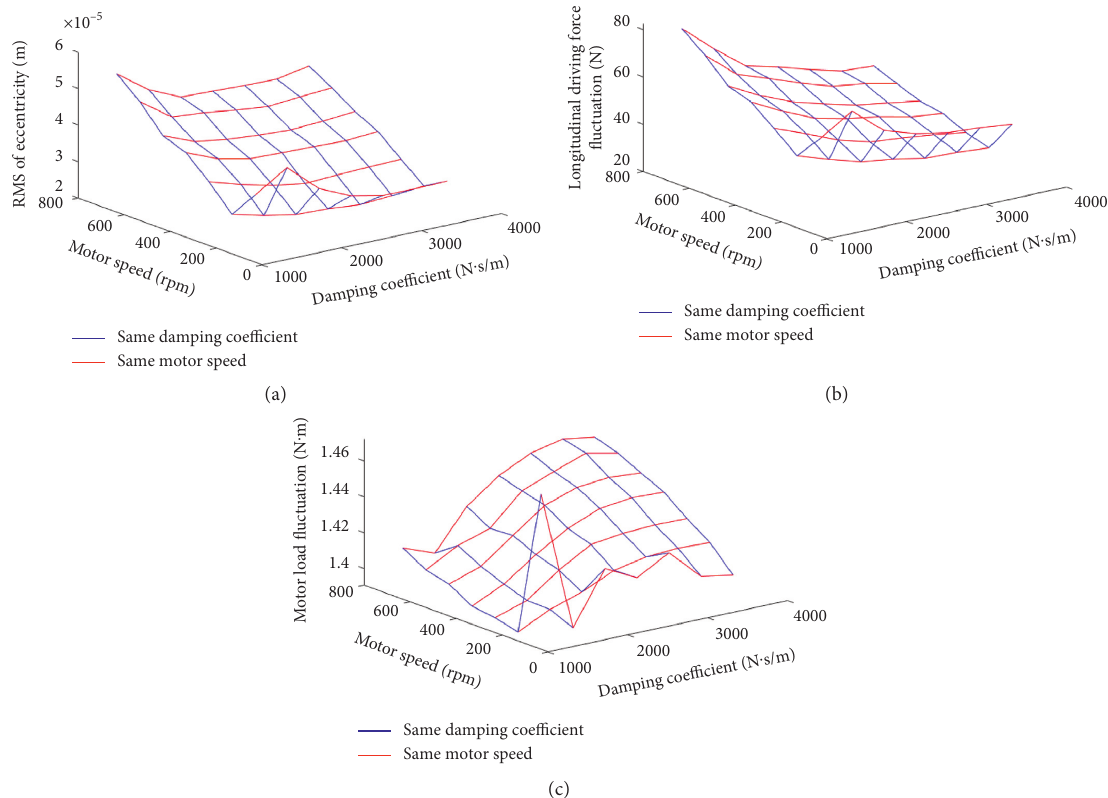
Figure 12: RMS and fluctuation values of longitudinal evaluation indices under different damping coefficients and motor speeds. (a) Eccentricity. (b) Longitudinal driving force. (c) Motor load.